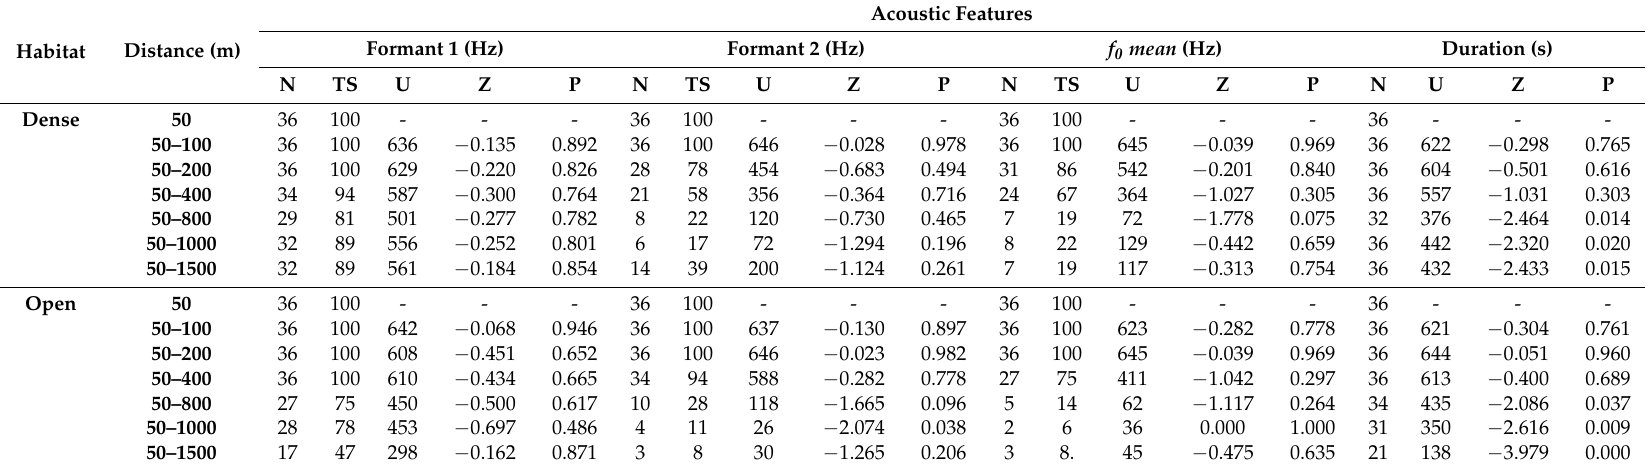
Table 2. Acoustic features recorded and measured at 50 m compared to all other distances ranging from 100–1500 m using Mann–Whitney U tests.